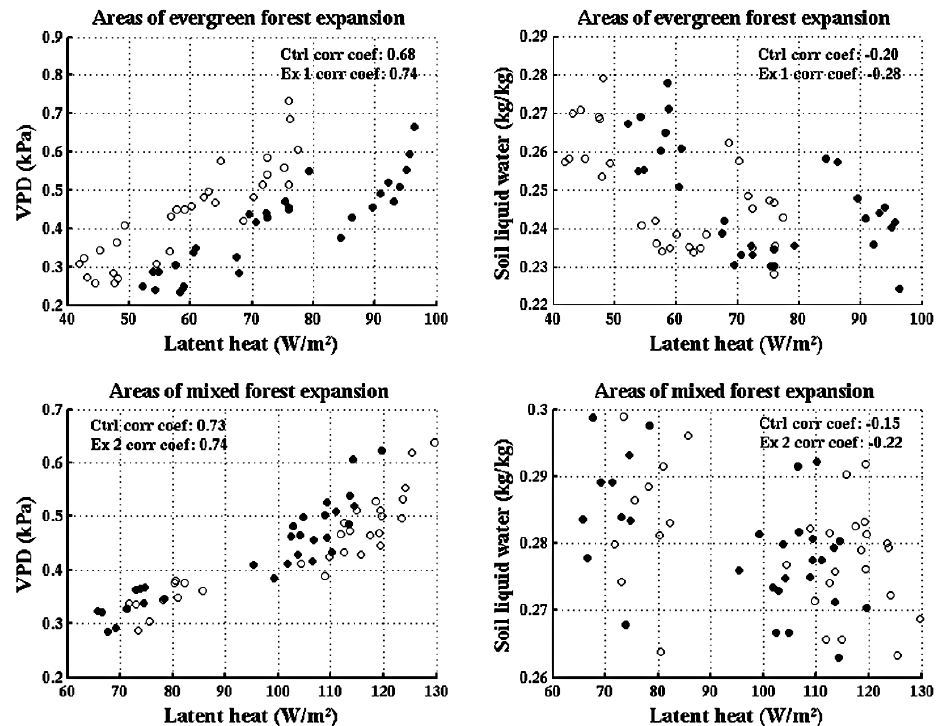
Figure 11. Effect of change in vegetation cover on the relationship between the monthly mean latent heat flux and VPD at 2m (left panels), and latent heat and liquid soil moisture content in the top soil layer (right panels). The data are based on summer season (JJA) monthly means, averaged over areas with northward-expanding evergreen forest (upper panels) and areas with northward migrating mixed forest (bottom